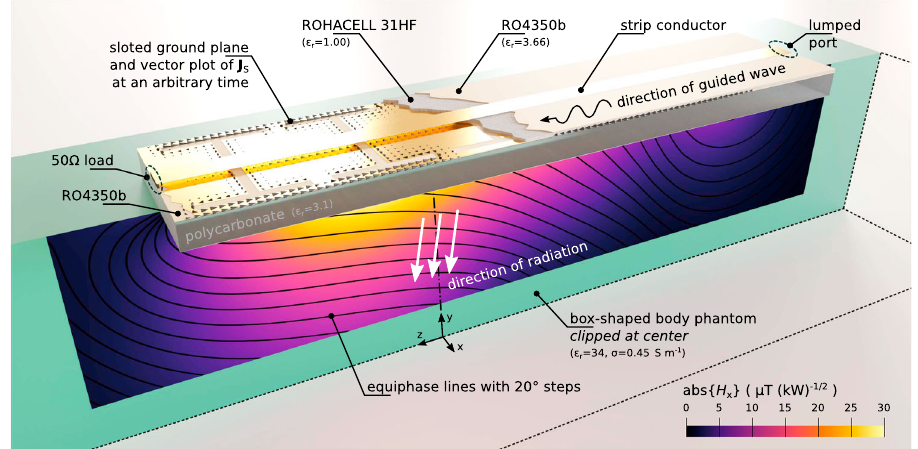
Fig. 1 Proposed RF excitation mechanism through non-resonant radiation of leaky waves. The exciting slotted microstrip line radiates into a box-shaped human body phantom for body MRI RF excitation. The color plot shows the normalized magnitude of the simulated H x distribution, while black contours represent wavefronts in the conductive medium. Calculated surface current density distribution on the slotted ground plane is shown with black arrows.